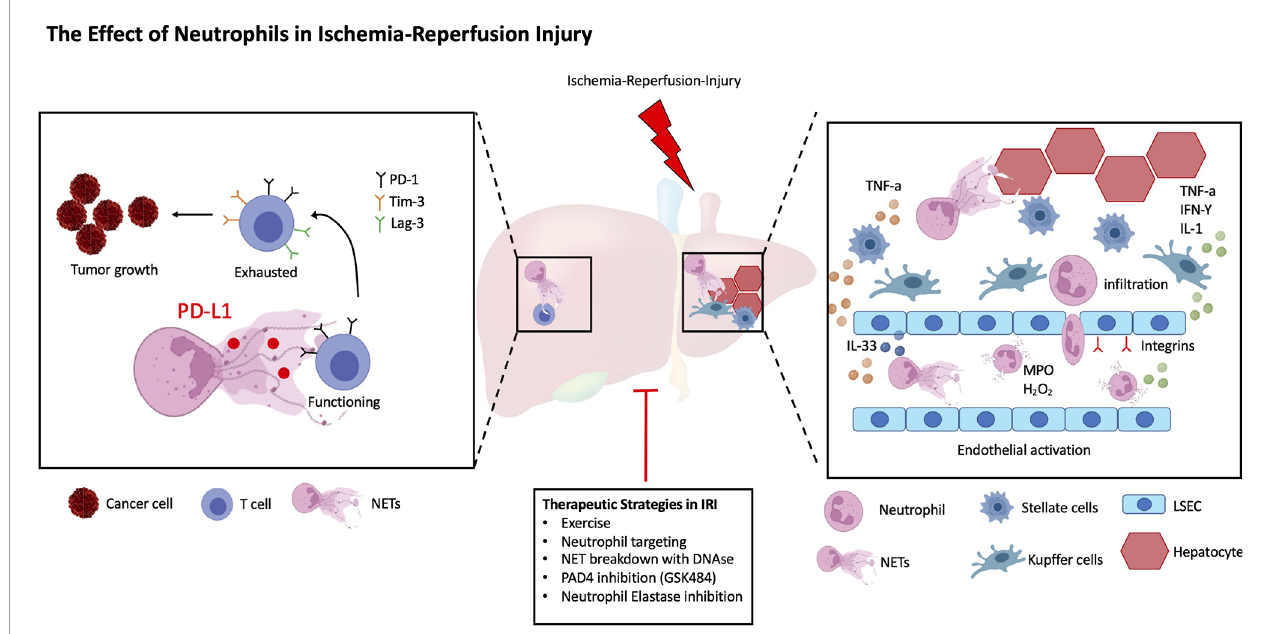
FIGURE 1 | The Role of Neutrophils in Ischemia-Reperfusion Injury. A simpli fi ed schematic representation of the roles of Neutrophils in liver IRI. Following IRI liver parenchymal cells promote the recruitment, activation, and phenotypic differentiation of neutrophils. LSECs increase the production of NETs via IL-33 signaling, in addition they upregulate adhesion markers to facilitate Neutrophil transmigration, extravasation and NET formation. Similarly, both HSCs and Kupffer cells secrete cytokines to increase Neutrophil homing. Within the tumor microenvironment (TME), NETs promote the exhaustion of T cells leading to increased tumor burden. Several, both non-pharmacological and pharmacological therapies have been described to decrease liver